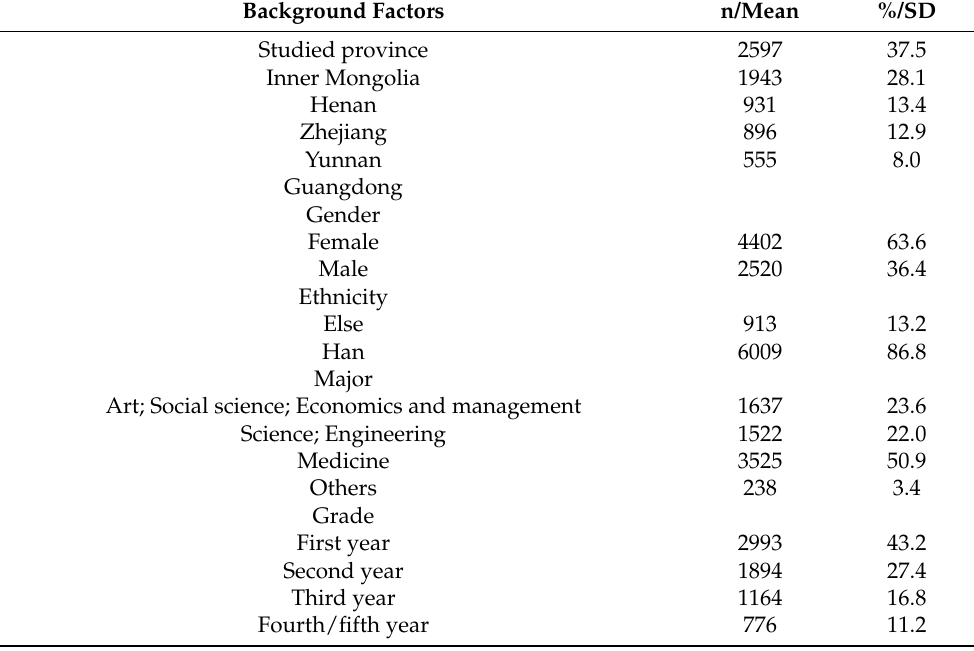
Table 1. Descriptive